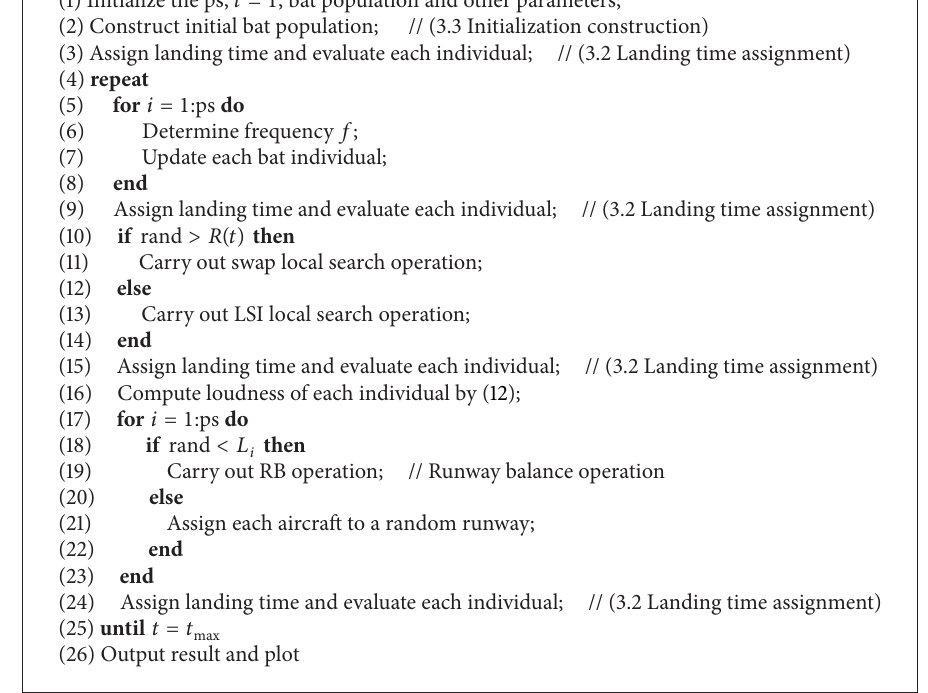
Algorithm 1: The pseudo-code of HBA for ALP.